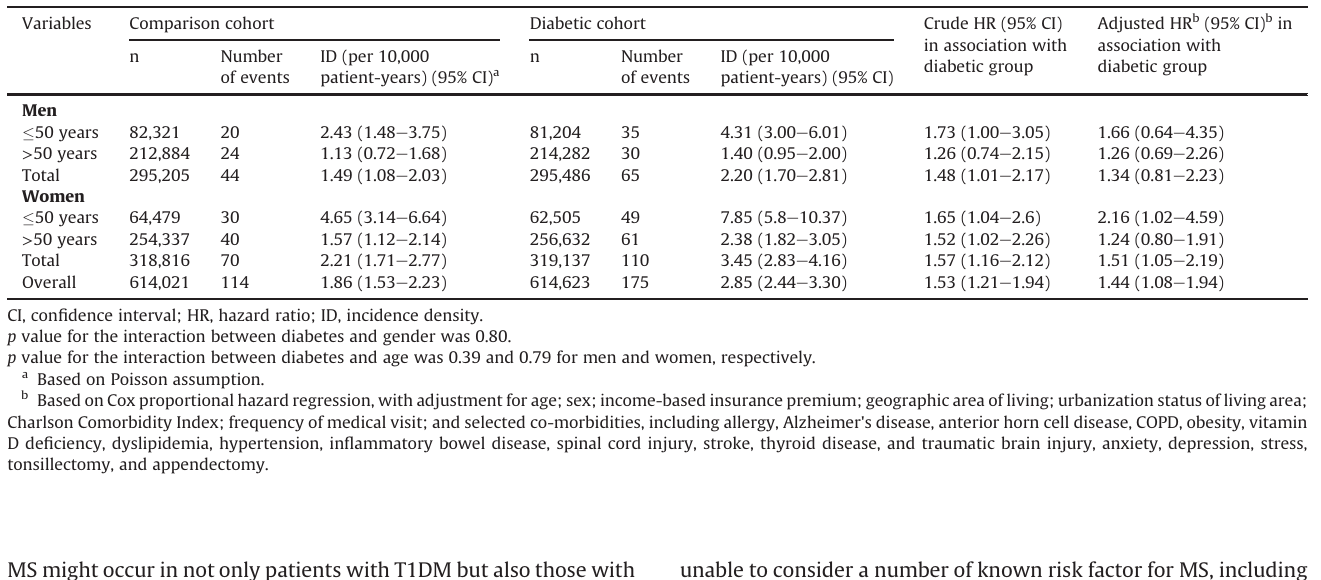
Table 2 Overall and gender- and age-speci fi c incidence densities and relative hazards of multiple sclerosis in the diabetes and comparison cohorts. Variables Comparison cohort Diabetic cohort Crude HR (95% CI) groupn Number of events